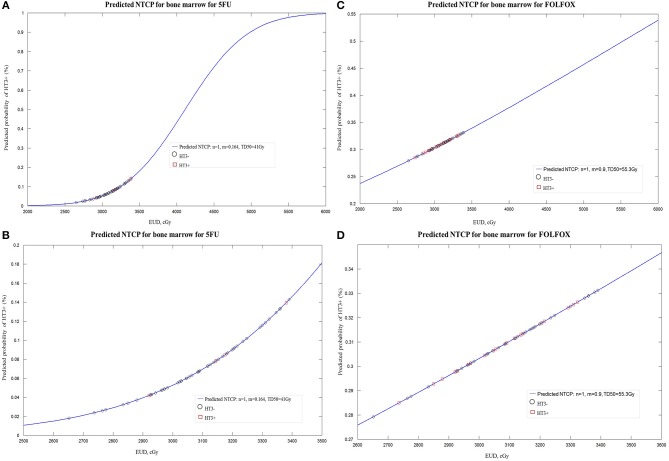
(A) Lyman-Kutcher-Burman normal tissue complication probability (NTCP) model for grade≥3 (HT3+) in patients treated with 5FU. Squares represent patients with HT3+. Open circles represent patients without HT3+. (B) Enlarged portion of (A). (C) Lyman-Kutcher-Burman normal tissue complication probability (NTCP) model for grade≥3 (HT3+) in patients treated with FOLFOX. (D) Enlarged portion of (C).